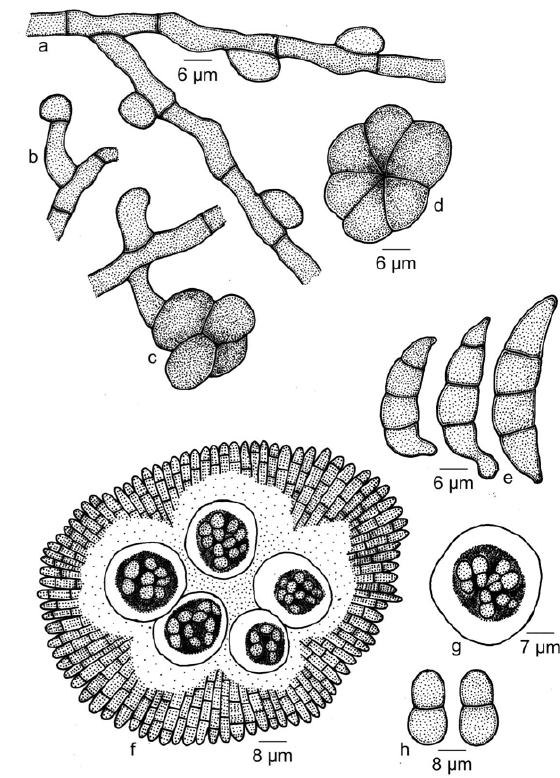
Figure 194. Schiffnerula ricini a.Appressoriate mycelium, b.Conidiophore, c. Sarcinella conidia on conidiophore, d. Conidia of Sarcinella , e. Conidia of Questieridiella , f. Thyriothecium, g. Ascus, h.